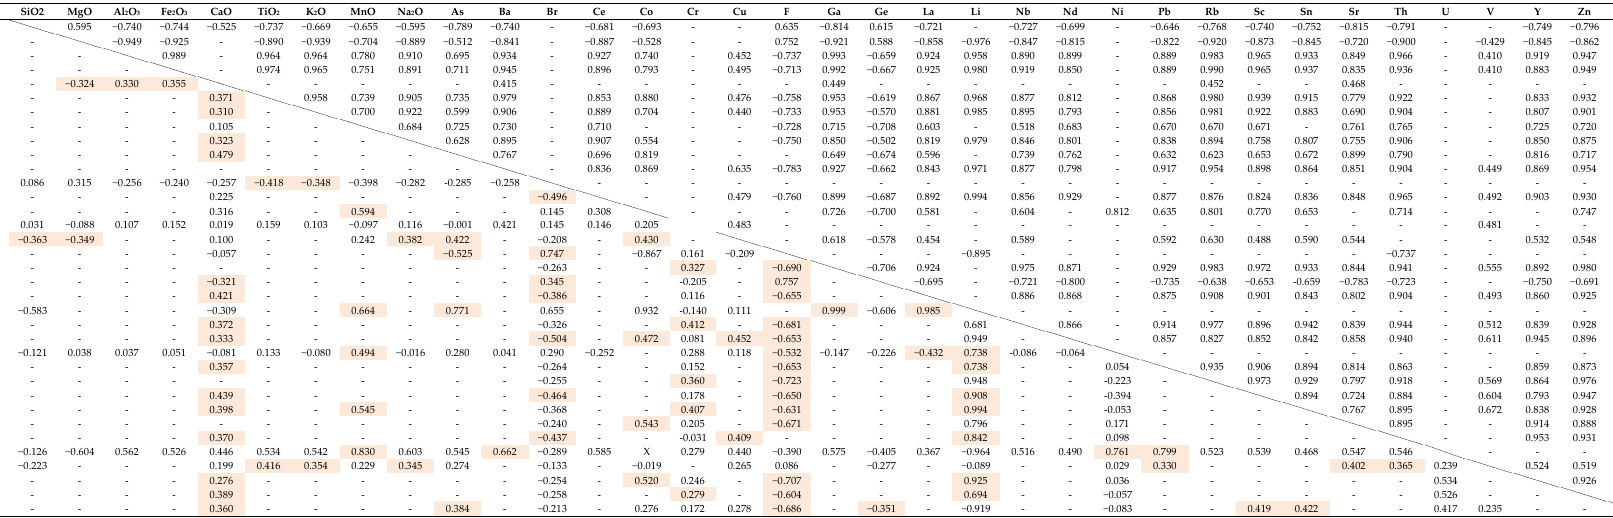
Table A2. Pearson correlation coefficients of major and trace elements data. All data above the diagonal have a p -value less than 0.01; the values under the line showing a light brown shading have a p -value between 0.1 and 0.01; and all other values have a p -value greater than 0.1.